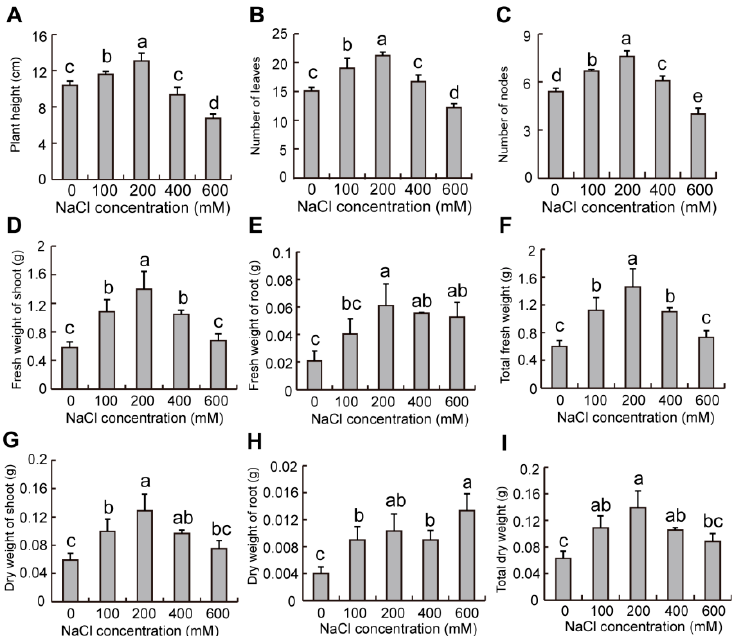
Figure 8. Effects of NaCl on the morphological indicators of plants from brown seeds of S. liaotungensis . The determination of plant height ( A ), numbers of leaves ( B ) and nodes ( C ), fresh weight of shoot ( D ), root ( E ), and total ( F ), and dry weight of shoot ( G ), root ( H ), and total ( I ) of plants from brown seeds. There were 5 plants counted for each replicate. Different letters show significant differences (LSD test, p < 0.05).